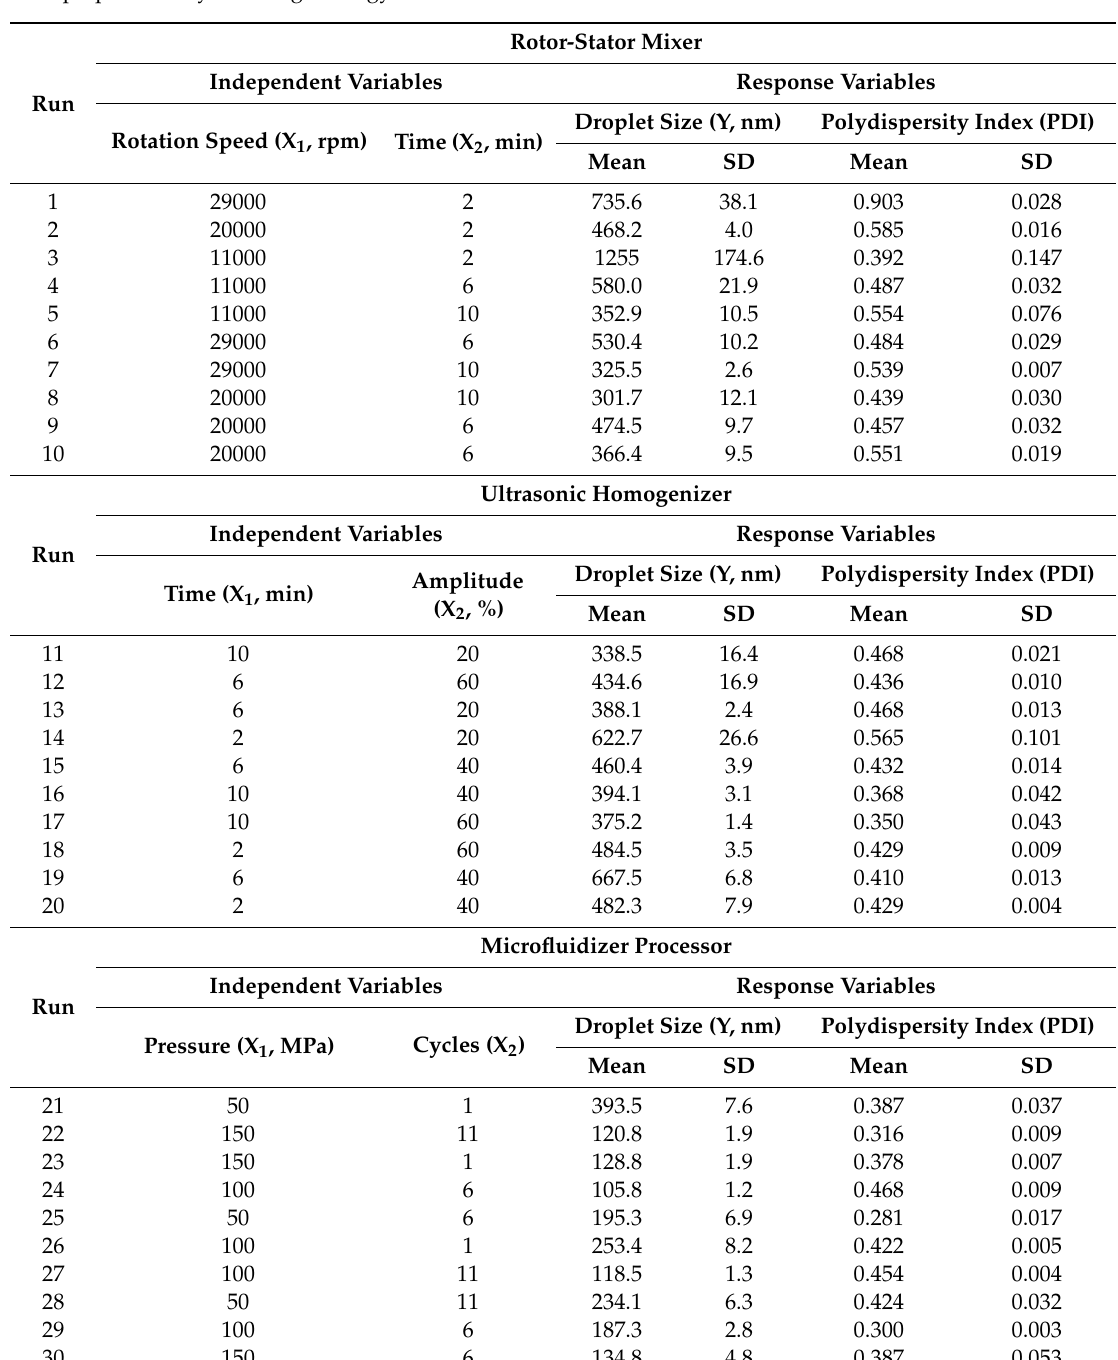
Table 2. Experimental matrix based in a central composite design (CCD) for W / O / W double emulsion preparation by three high-energy emulsification